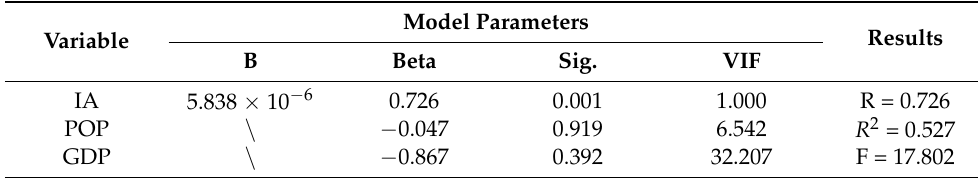
Table 2. Regression analysis